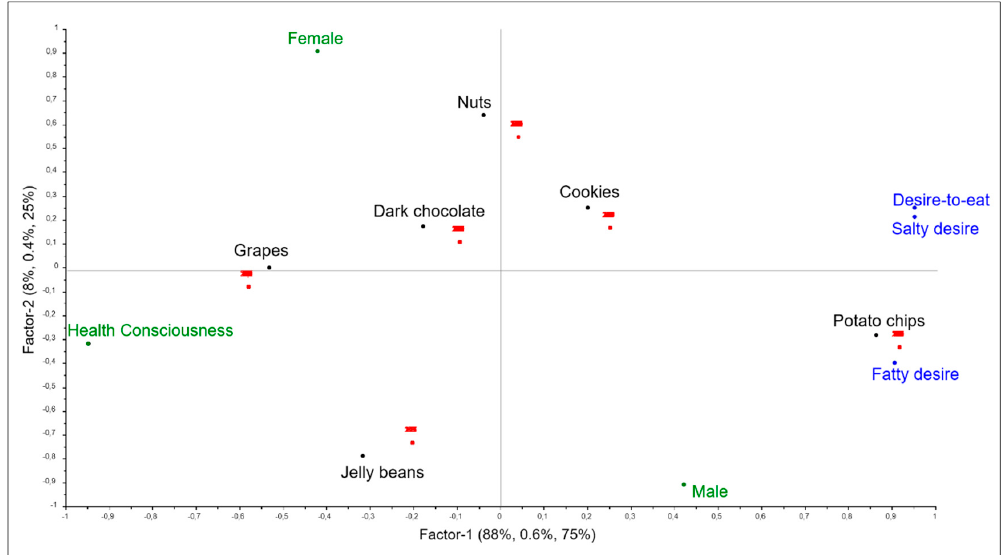
Figure 5. Correlation loadings from L-PLS regression analysis showing consumers’ real choice ( ● ) for the six snacks ( ● ), explained by both subjective sensations ( ● ) and background variables ( ● ). The plot displays Factor 1 (X explained variance: 88%, Y: 0.6%, Z: 75%) vs. Factor 2 (X explained variance: 8%, Y: 0.4%, Z: 25%). Variables not explanatory for choice were omitted through preliminary full cross- validated two-block PLS regression analyses.